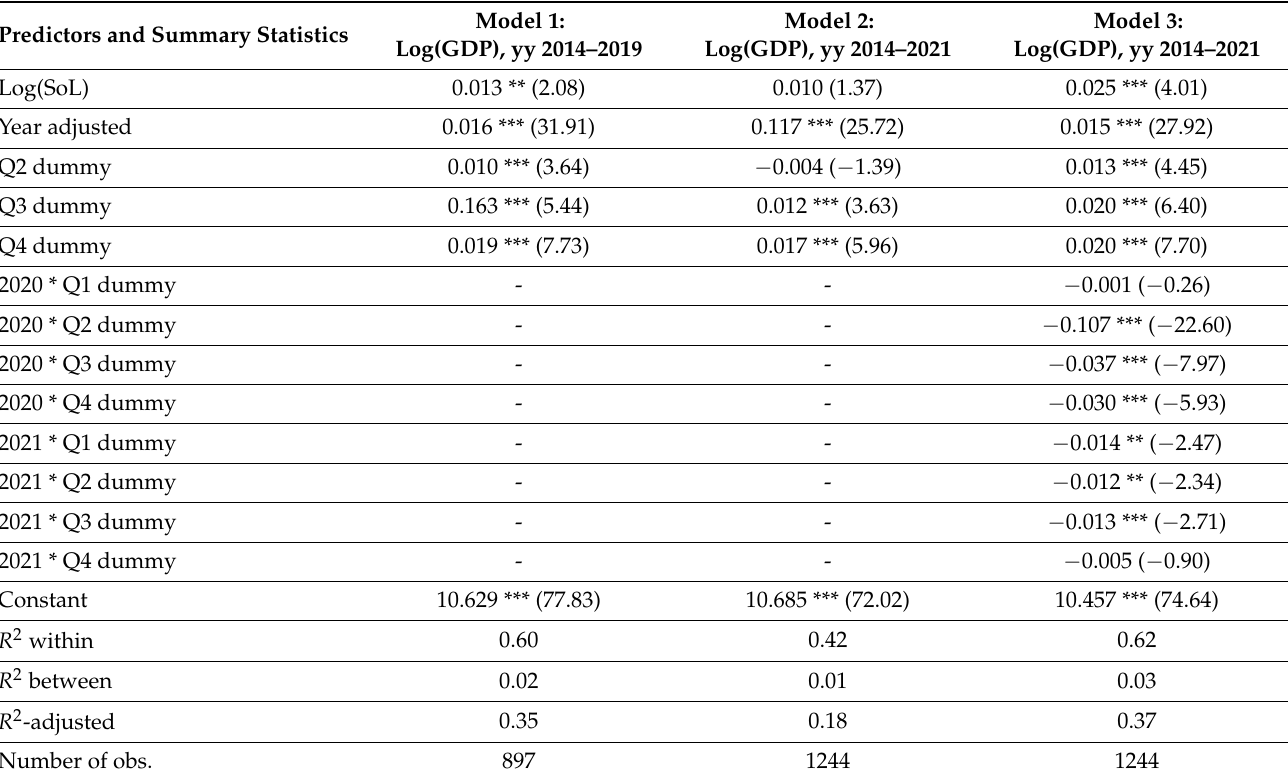
Table 1. Association between GDP and NTL before and after the COVID-19